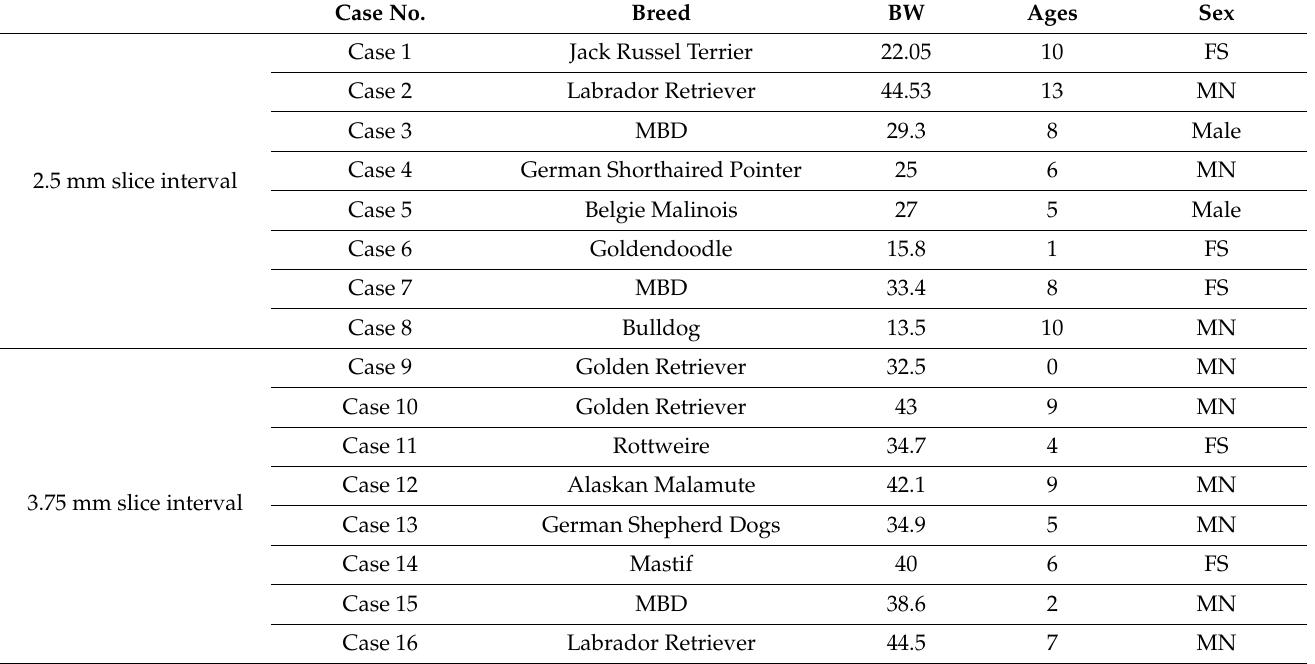
Table 1. Summary of clinical information of dogs without hepatic diseases. Patients from 1 to 8 were with 2.5 mm slice intervals, whereas patients 9 to 16 were with 3.75 mm slice intervals. Case No. Breed BW